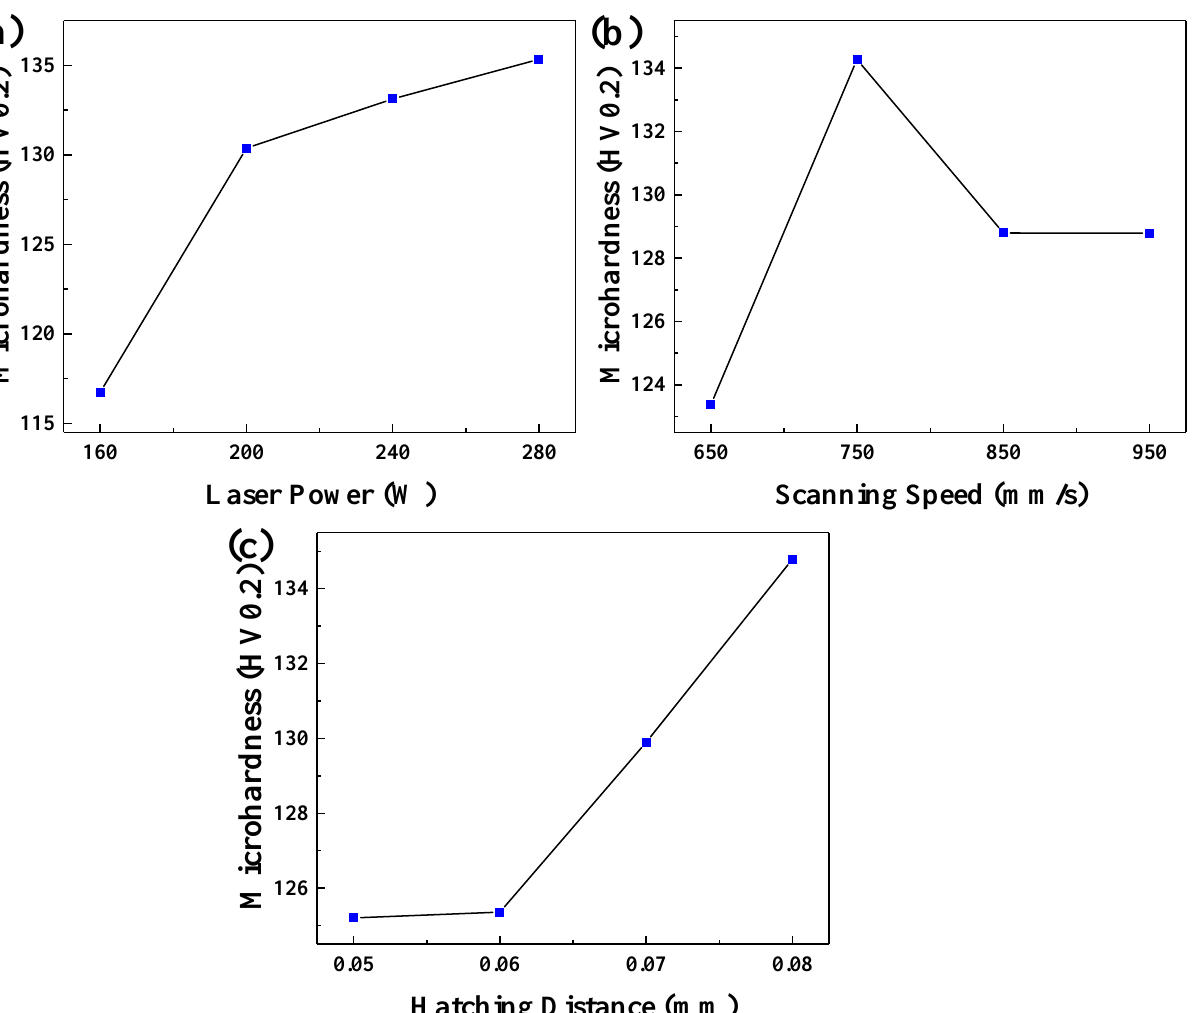
Figure 7. The influence of process parameters on the hardness of samples: ( a ) Laser Power, ( b )